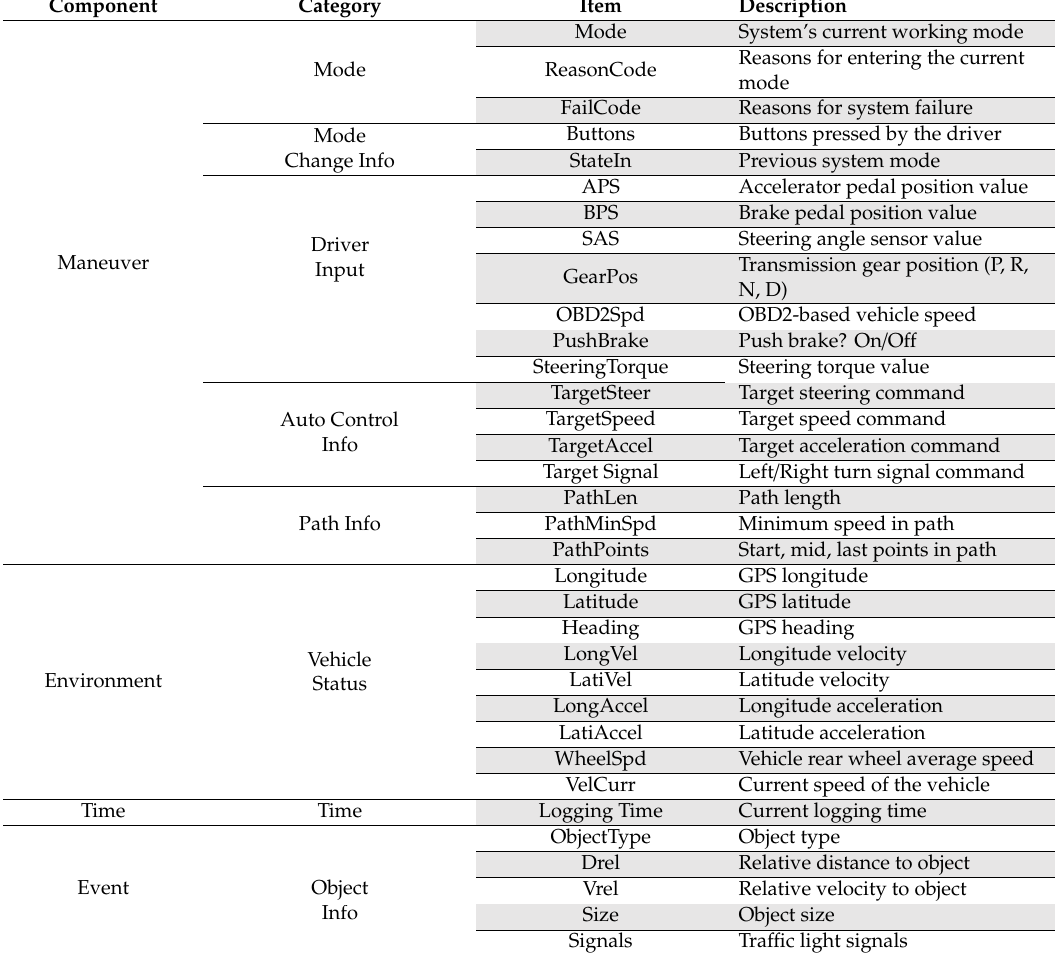
Table 2. Details of logging items for an autonomous driving